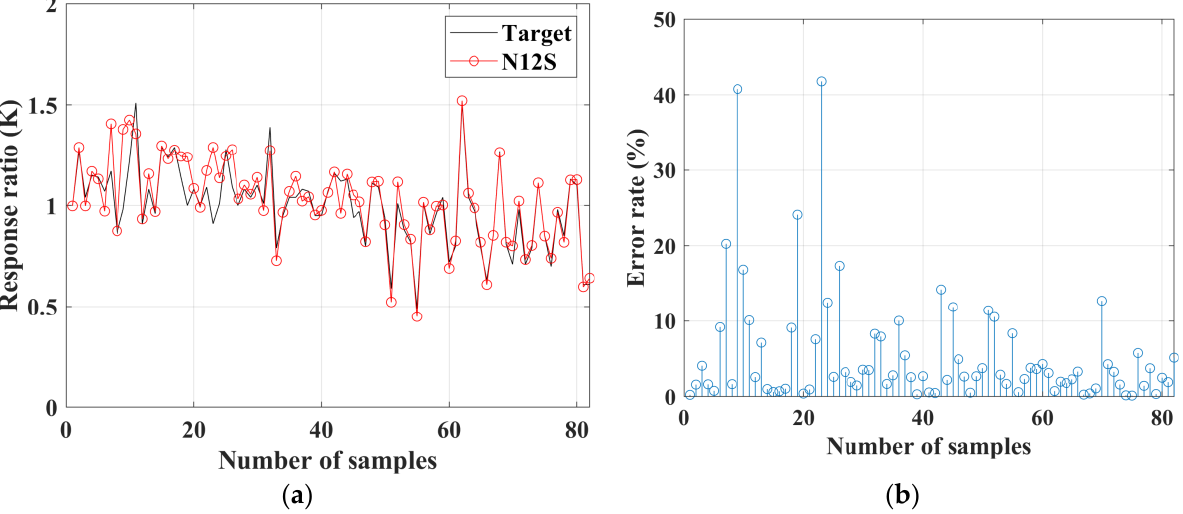
Figure 10. Performance of N12S model. ( a ) Comparison between target and prediction of N12S. ( b ) Error rate of N12S prediction.